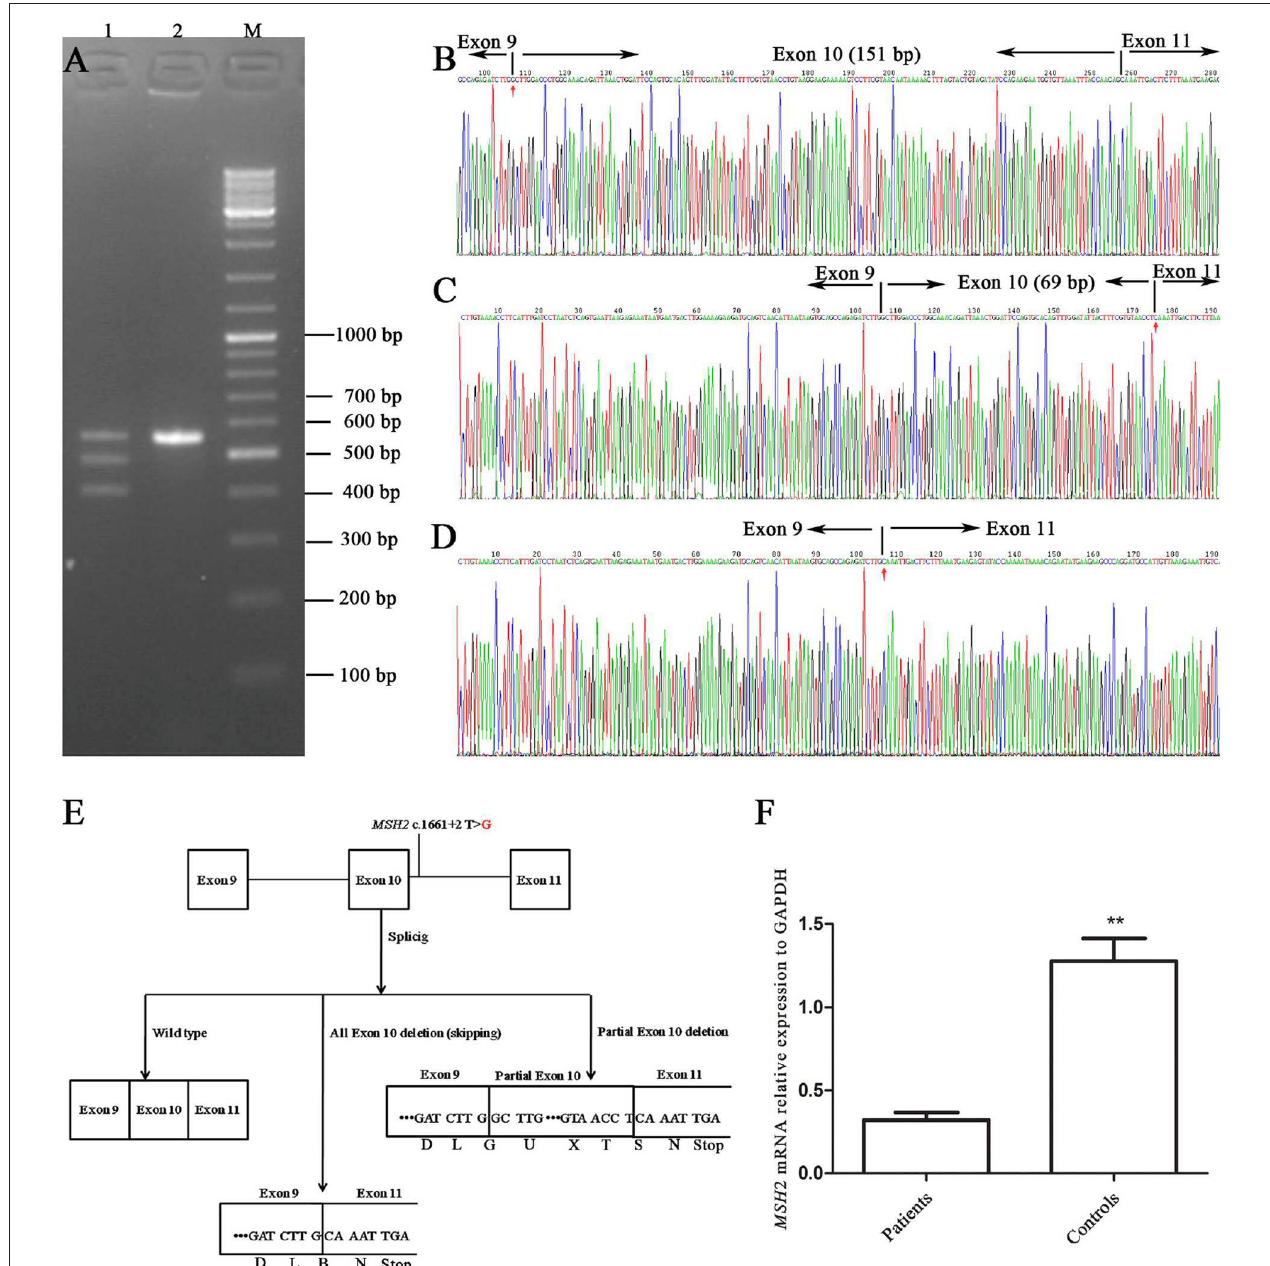
FIGURE 3 | Alternative splicing of MSH 2c.1661 + 2T > G. (A) RT-PCR of genomic region encompassing exons 9, 10, 11, and 12 to characterize the abnormal splicing; 1: patient III-1; 2: control III-2; M: markers. (B–D) Sanger sequencing analysis of alternatively spliced products; (B) wild type; (C) 82-nucleotide deletion in exon 10; (D) entire exon 10 deletion. (E) Schematic representation of splicing models. (F) qRT-PCR analysis of mutation carriers (II-2, III-1, and IV-1) and controls (II-1, III-2 and another healthy volunteer). Results are expressed as the mean ± SE (** P <